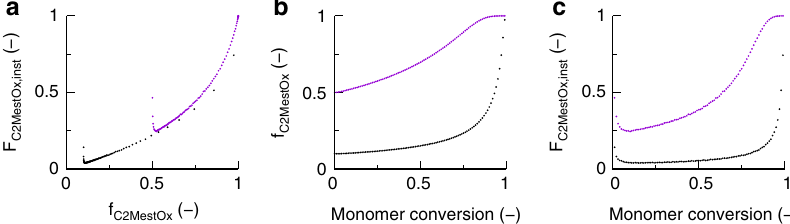
Fig. 4 Conventional analysis of 2-oxazoline comonomer incorporation. a Average instantaneous functionalization ( F C2MestOx,inst ) as a function of the feed composition based on the functional comonomer ( f C2MestOx ). b f C2MestOx as a function a function of the (overall) monomer conversion. c F C2MestOx,inst as a function the (overall) monomer conversion; CROP of MeOx and C2MestOx under equimolar initial conditions (conditions: Fig. 3); purple and black dots: initial amount of C 2MestOx ( f C2MestOx,0 ) of 50 and 10 mol %; for a almost coinciding with terminal Mayo-Lewis equation (Equation (1)); cumulative